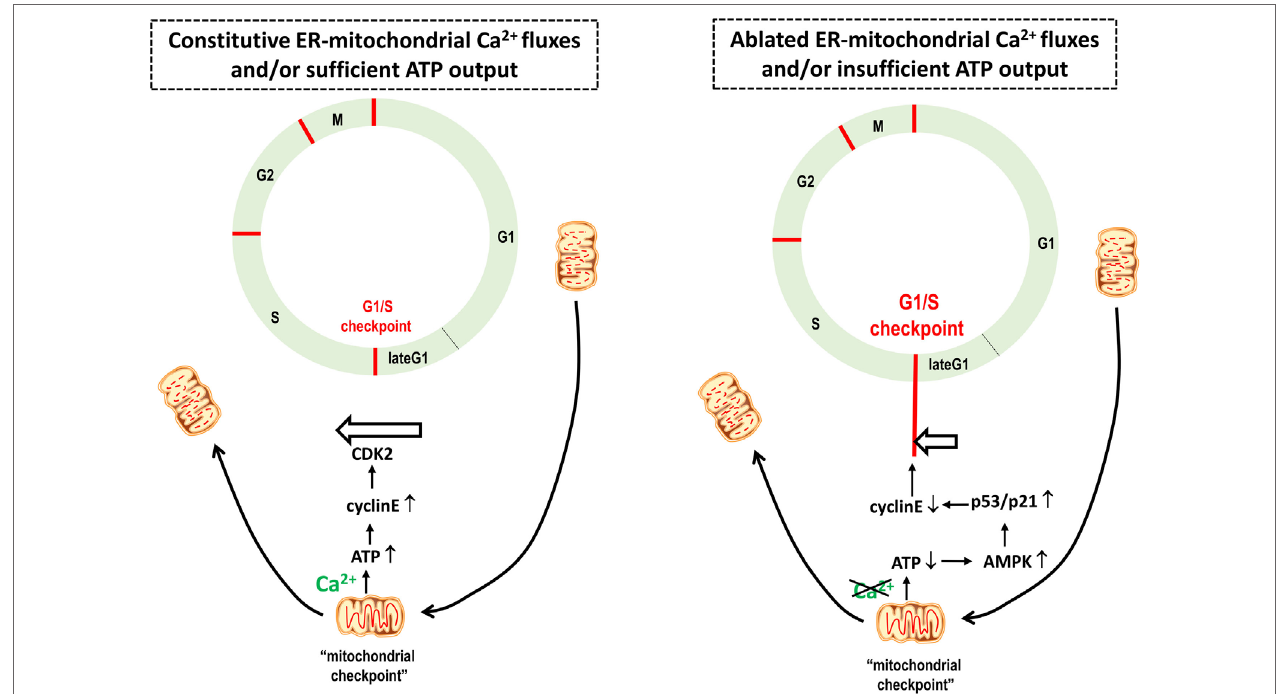
FiGURe 3 | A boost in mitochondrial ATP output provides a mitochondrial checkpoint for cellular health, enabling cells to bypass the G1/S checkpoint and cell cycle progression . Based on Mitra et al. (106), mitochondrial structure changes along the cell cycle progression. At the late G1 phase, the mitochondrial structure changes into a giant, single tubular network, electrically coupled and hyperpolarized, boosting ATP production. The G1–S transition that ensures the initiation of DNA replication is controlled by the cyclin E, which, in turn, further binds and activates CDK2. Cyclin E is upregulated upon increased ATP output, enabling S-phase progression and proliferation. Non-tumorigenic cells experiencing a reduction of ATP production due to compromised mitochondrial bioenergetics will trigger the G1/S checkpoint arrest due to AMP-activated kinase (AMPK) activation and subsequent phosphorylation and activation of the tumor suppressor protein p53 that in turn downregulates cyclin E protein levels. In tumorigenic cells, it is anticipated that this tight link between adequate mitochondrial bioenergetics and the G1/S checkpoint is lost. Hence, cancer cells can progress through the cell cycle irrespective of their mitochondrial bioenergetic status. Thus, a mitochondrial bioenergetic crisis will slow down the cell cycle and proliferation in normal cells, while in cancer cells, the cell cycle will continue, eventually resulting in a mitotic